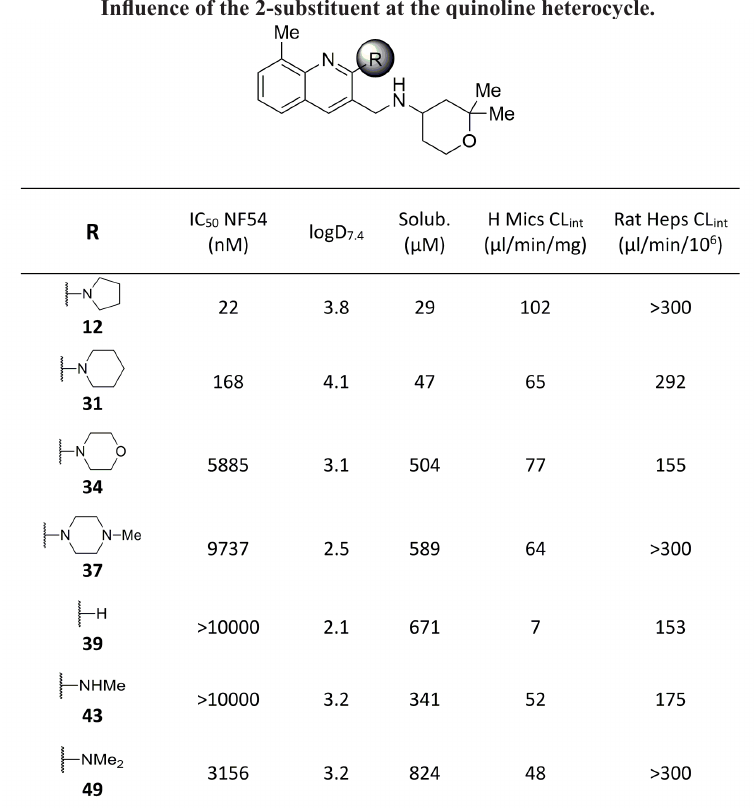
Influence of the 2-substituent at the quinoline